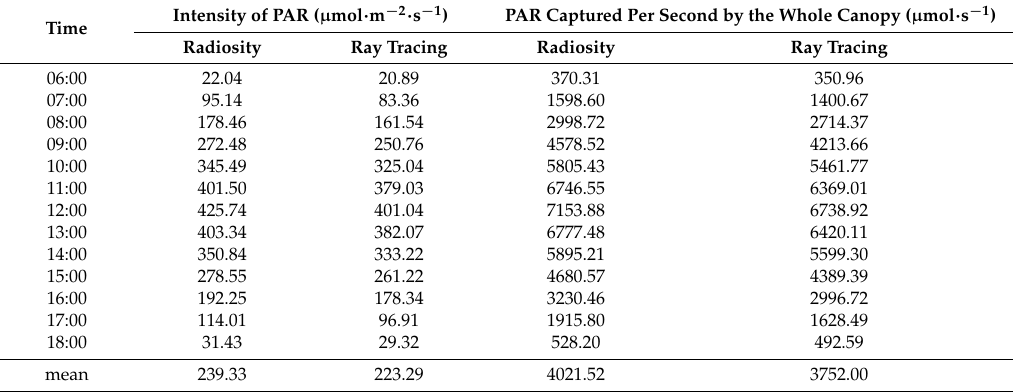
Table 2. Comparison of direct solar PAR parameters that were simulated hourly based on radiosity and ray tracing within the loquat canopy.